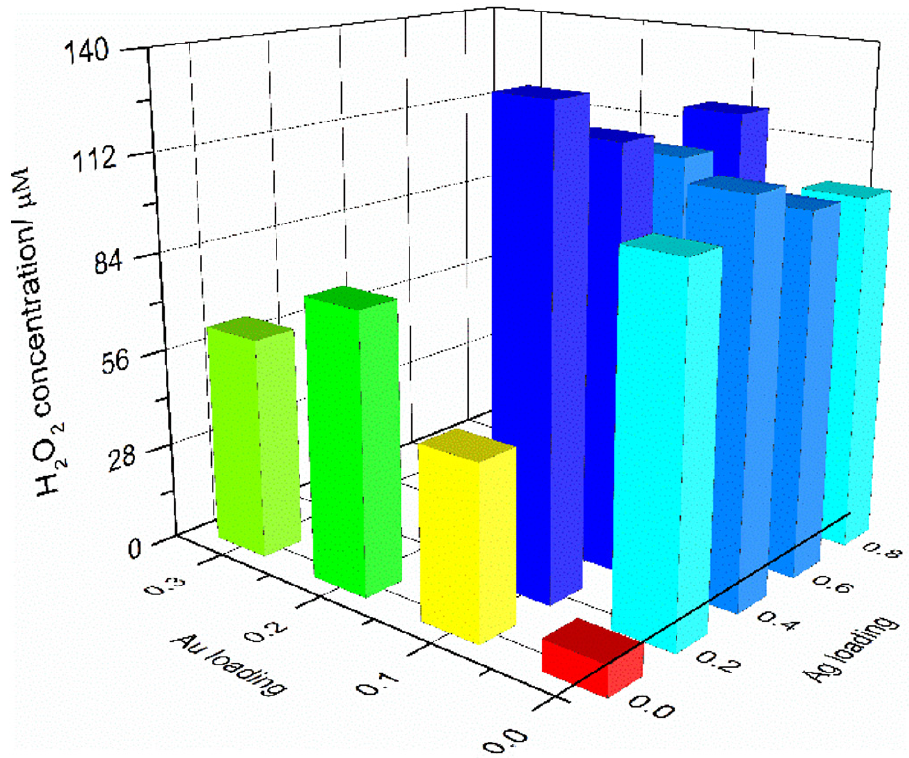
Figure 4. H 2 O 2 yield on modified TiO 2 after one hour illumination (50 mg catalyst in 100 mL 0.1 M methanol